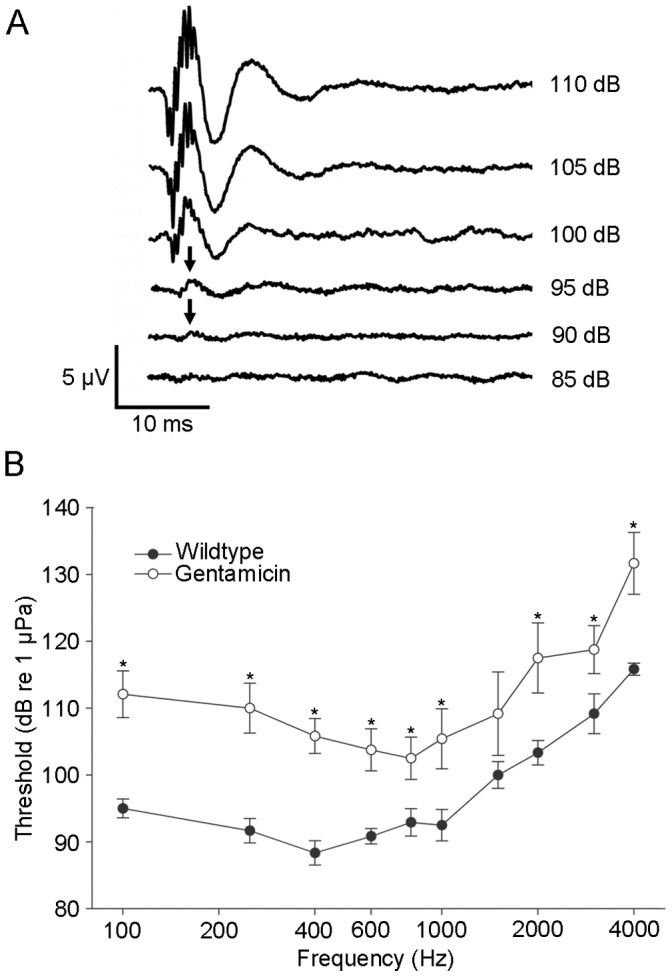
Gentamicin treatment causes auditory threshold shifts following 24 hours of treatment.(A) Electrophysiological recordings of auditory evoked potentials (AEPs) measured at a test frequency of 1000 Hz. Stimulus intensity was decreased from 110 dB to 85 dB in 5 dB steps. The AEPs emerge as a series of peaks (black arrows). In this example, the auditory threshold, as judged by visual inspection, is 90 dB (re: 1 µPa). (B) Auditory thresholds were used to construct audiograms to compare auditory function in treated and control fish. There was a significant auditory threshold shift (*p<0.05) at almost every frequency tested in gentamicin-treated fish when compared to untreated controls. n = 6 animals per treatment.